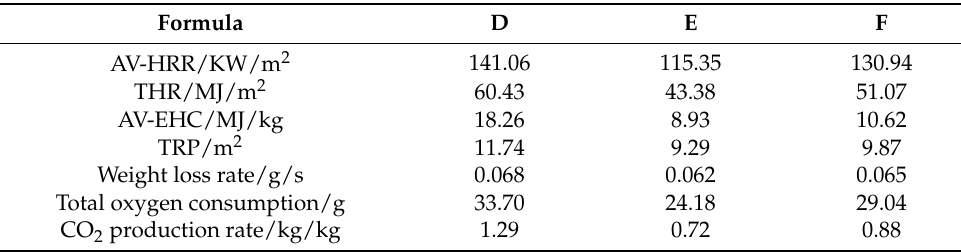
Table 3. Data of cone calorimeter of HPN-EPPA-UR-PA